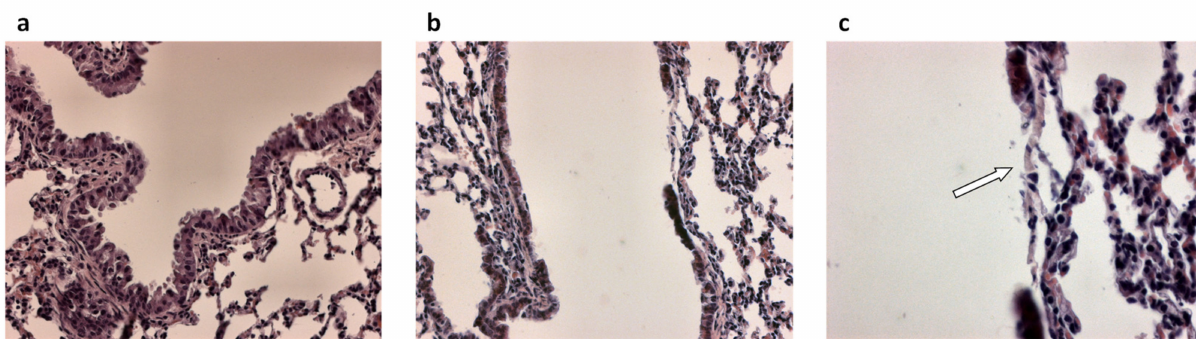
Figure 1. Airway epithelial damage in the airways following infection with P. aeruginosa . ( a ) Hematoxylin and eosin-stained lung section from control mice and ( b , c ) hematoxylin and eosin-stained lung sections from P. aeruginosa infected mice 48 h post-intratracheal instillation at a dose of 1 × 10 5 colony forming units. Panel c is an enlargement of panel b . Original magnification × 20 ( a , b ) and × 40 ( c ). White arrow in ( c ) indicates loss of the airway